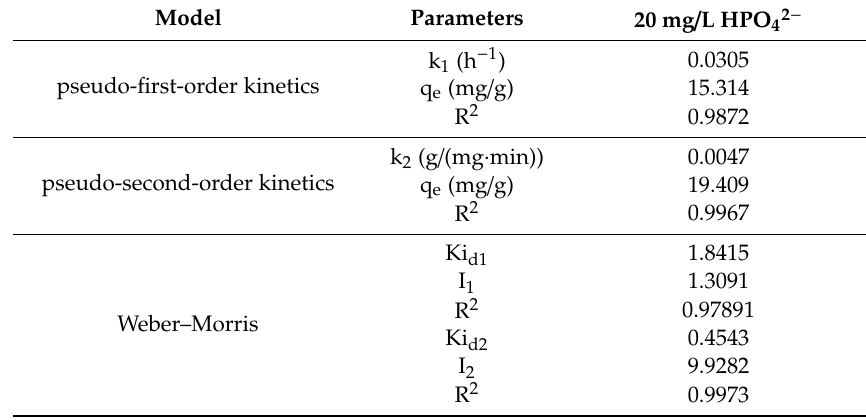
Table 1. Kinetic parameters obtained from pseudo-first-order, pseudo-second-order kinetic and intra-particle di ff usion